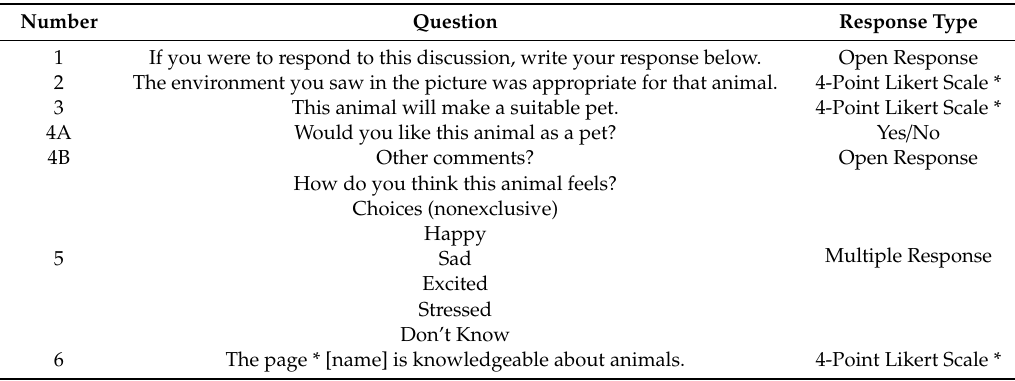
Table 3. Survey questions used for all treatments and their response types. *Name would be “Animal Freedom” for negative posts, “Monkey Babies” for positive